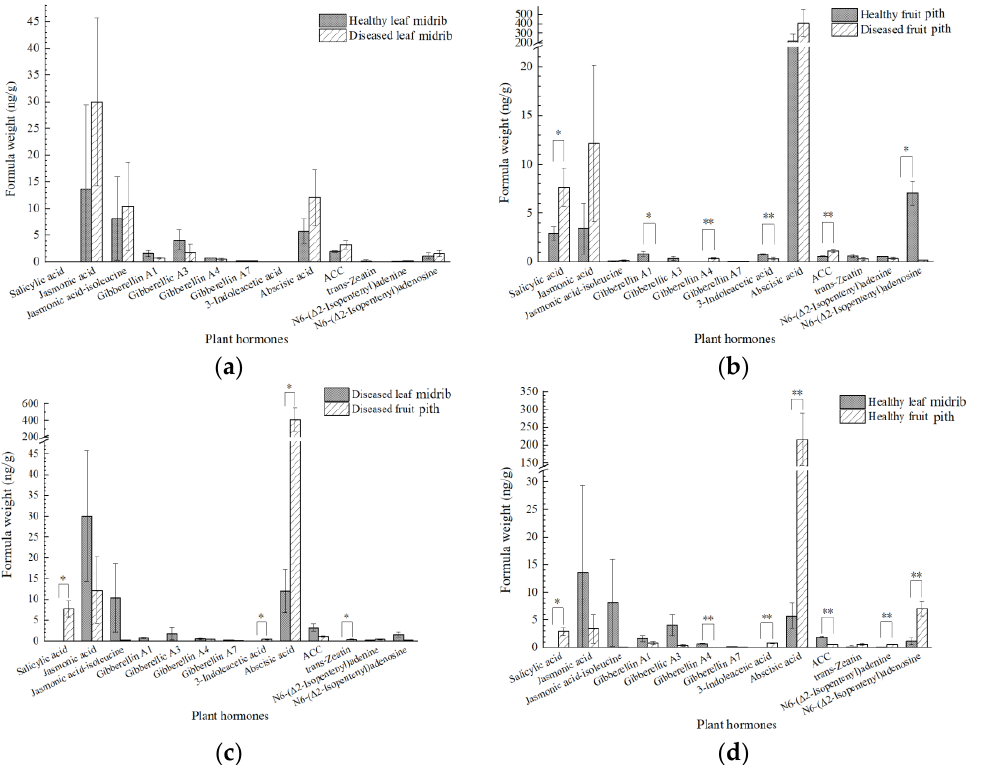
Figure 8. Endogenous phytohormone content in “ Candidatus Liberibacter asiaticus” infected or uninfected leaf midribs and fruit piths. ( a ) Endogenous phytohormone content in CLas-infected and –uninfected leaf midribes. ( b ) Endogenous phytohormone content in CLas-infected and -uninfected fruit piths. ( c ) Endogenous phytohormone content in CLas-infected leaf midribes and fruit piths. ( d ) Endogenous phytohormone content in healthy leaf midribes and fruit piths. Data are represented as mean ± standard deviation. ACC, 1-aminocyclopropanecarboxylic acid. Means marked with asterisks are significantly different from corresponding control values (LSD test, * indicates p < 0.05, ** indicates p < 0.01).